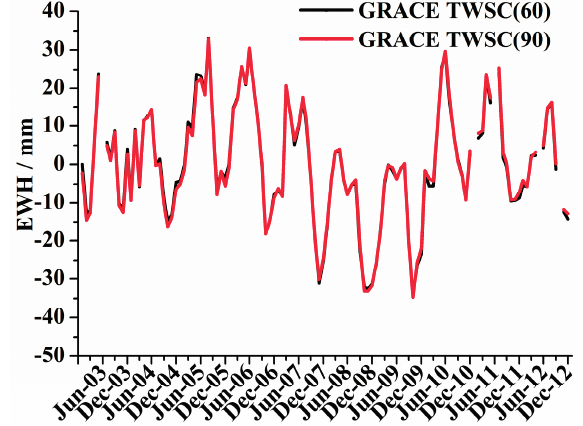
Figure 14. GRACE TWSC with spherical harmonic coefficients truncated to degree and order of 60 and